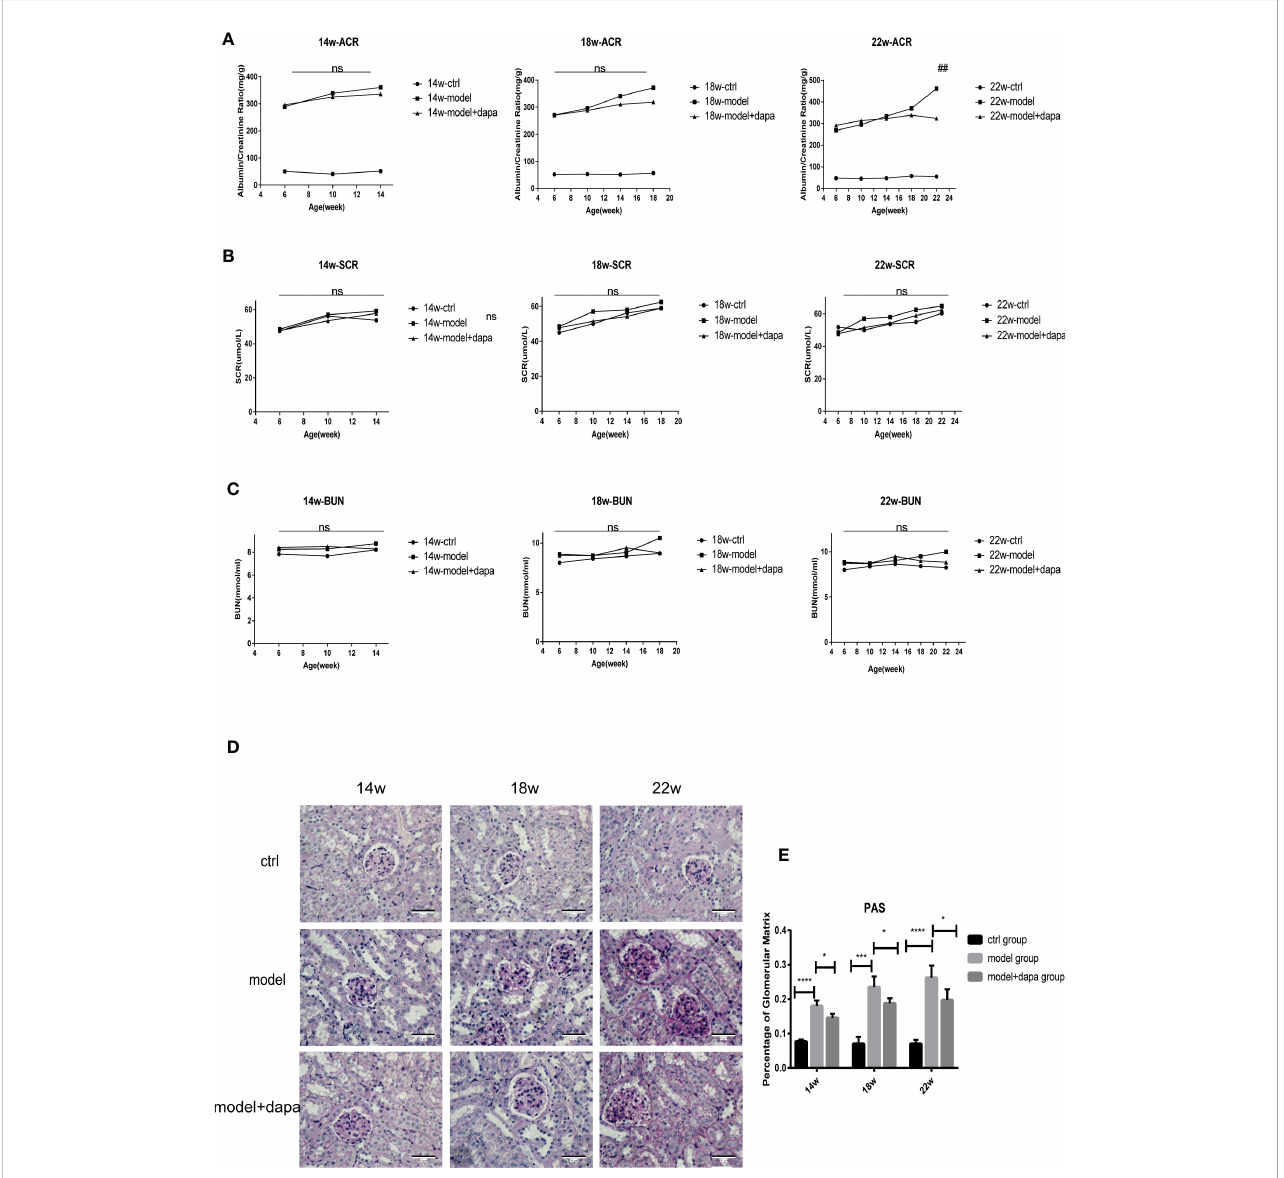
FIGURE 2 DAPA effectively slows the progression of DKD in db/db mice. (A – C) Albumin to creatinine ratio (ACR), scr, and bun levels were determined every 4 weeks in the mice of three groups throughout 14 weeks (14w), 18 weeks (18w), and 22 weeks (22w). (D, E) Periodic acid-Schiff (PAS) staining analysis of the histopathological changes among three groups at 14w, 18w, and 22w. original magni fi cation, x400. Scale bars, 50 µm. Data in (D) were quanti fi ed (E) . n = 4/group. Statistical signi fi cance was calculated using ANOVA with Tukey's test. *p < 0.05, ***p < 0.001, ****p < 0.0001. ns, not signi fi cant for the indicated comparison. Ns in (A) is for comparison between the model group and model + DAPA group, ns in (B, C) is for comparison among three groups. **p < 0.01 for model group vs mode; + DAPA